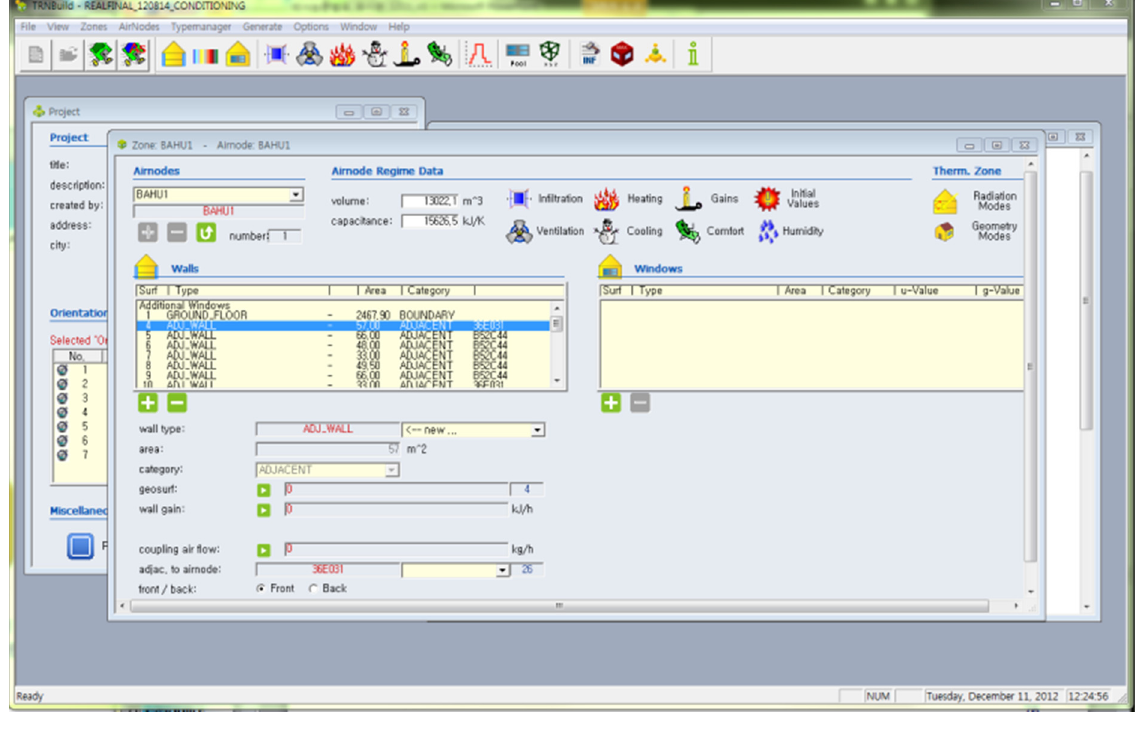
Figure 9. Trnbuild modeling.